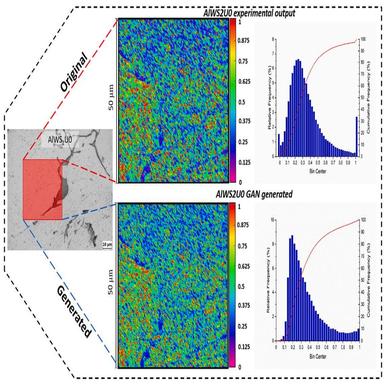
Al-WS2 normalized elastic modulus mapping graphical representation and comparison of frequency and cumulative distribution of original recording (Top) and GANs Re-generated datasets (Bottom).